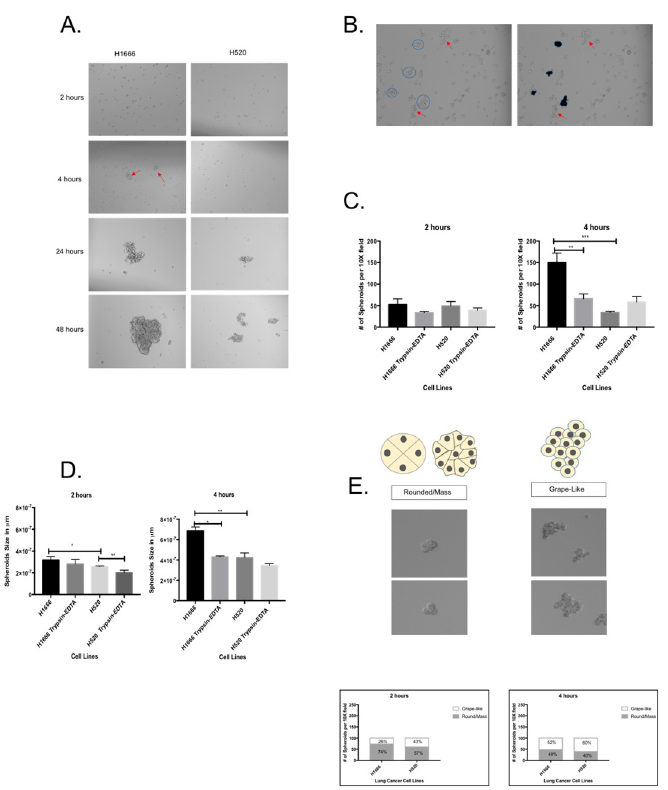
Fig 2. H520 cells have impaired cell-to-cell adhesion. (A) Photomicrographs of hanging drop H1666 and H520 cultures taken at 10X at 2, 4, 24, and 48 hours. Spheroids first appear at 4 hours in H1666 cells ( red arrows ), while in H520 cells they form at 24 hours, a time point at which H1666 cells already exhibit enlarged spheroids. (B) Photomicrograph of a H1666 cells hanging drop culture taken at 10X illustrating the spheroids identified by the ImageJ Particle Analysis Plug-in. Some aggregates are not detected as spheroids by ImageJ due to low compaction factor ( red arrows ), which denotes a lack of strong adhesion. (C) Graphs showing the total number of spheroids per 10X visual field at 2 and 4 hours. Control cultures were grown on 0.4% trypsin-EDTA to inactivate cadherin-based adhesion. (D) Graphs showing spheroid size in H1666 and H520 cells. No large difference between H1666 and H520 cells was detected at 2 hours, while at 4 hours H1666 spheroids were significantly larger than in H520 cells, with the size increase being reduced by 0.4% trypsin-EDTA. (E) At 2 hours the adhesive rounded/mass spheroid morphology predominates in H1666 cells, while the less adhesive grape-like morphology predominates in H520 cells. This trend continues at 4 hours. Statistical tests were assessed by Mann-Whitney tests when comparing two groups and Kruskal Wallis when comparing three groups or more. Statistical significance was set as: � p-value < 0.05, �� p-value < 0.01, and ��� p-value < 0.001. The cartoons were modified from Kenny et al., 2007.